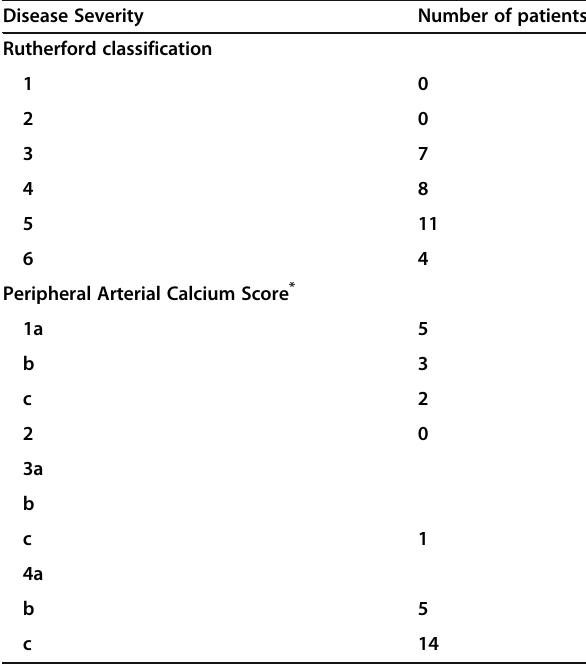
Table 1 Disease severity of patient